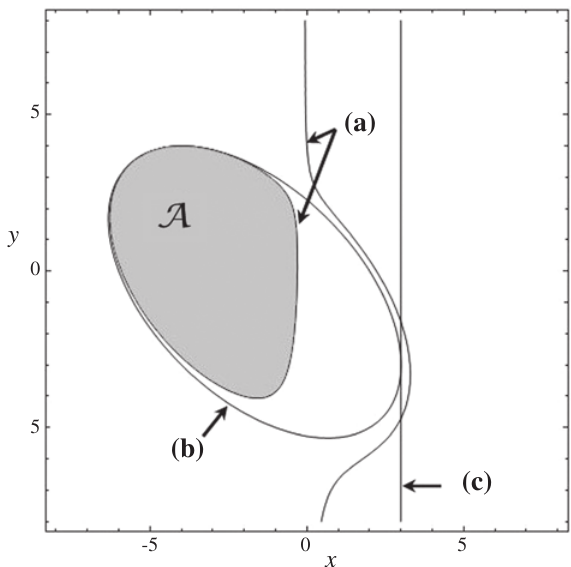
Figure 9: Semialgebraic set.